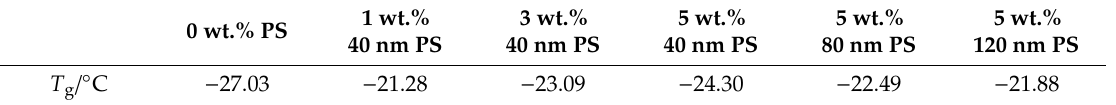
Figure 7. ( a ) Crystallization curve, ( b ) melting curve, and ( c ) derivative curve of modulation melting curve for temperature of blend films with different mass fraction. Table 1. The value of T g of various mass fraction of the composite